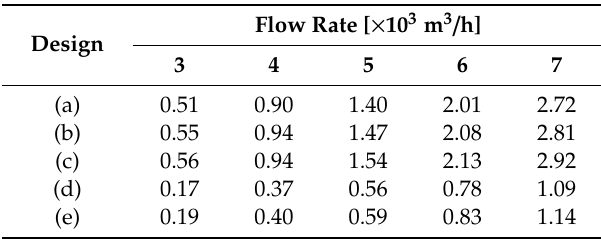
Table 2. Hydraulic losses [m] for the different designs and flow rates.